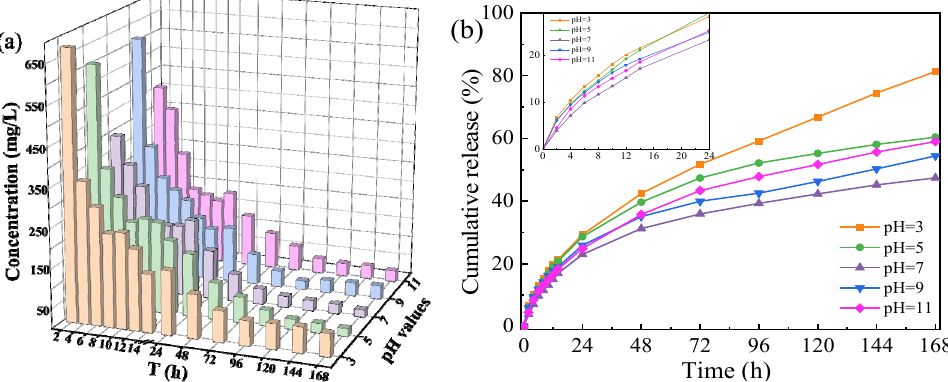
Figure 5. The three-times-tested average concentration ( a ) and the cumulative release ( b ) of OIM from OIM@PAM in different pH solutions at 25 °C.